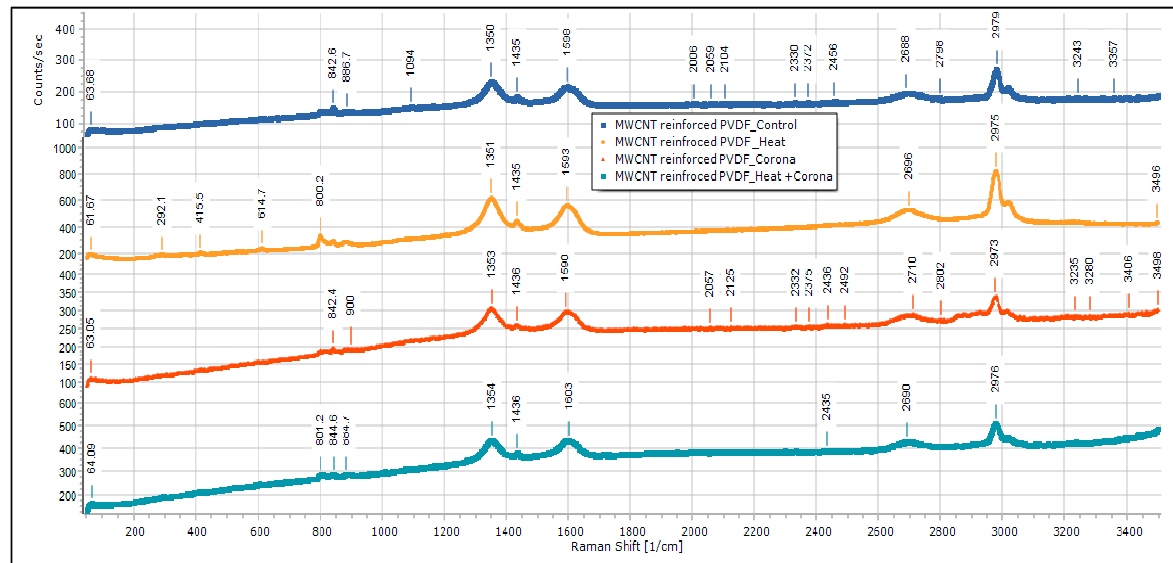
Figure 15. Raman results for MWCNT-reinforced PVDF membranes .